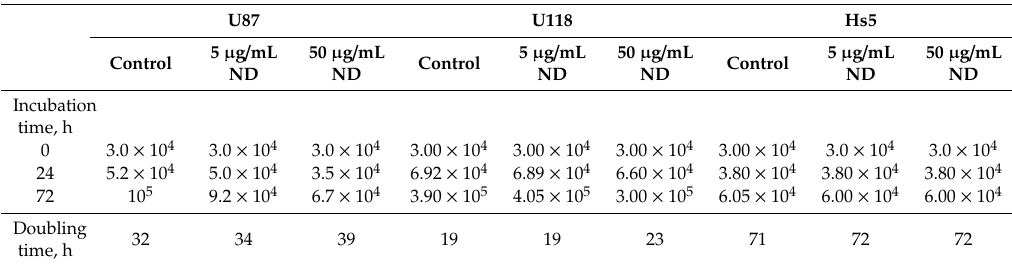
Table 1. Doubling time of U87, U118, and Hs5 cell lines after diamond nanoparticle (ND) treatment at concentrations of 5 and 50 μ g/mL for 24 and 72 h.